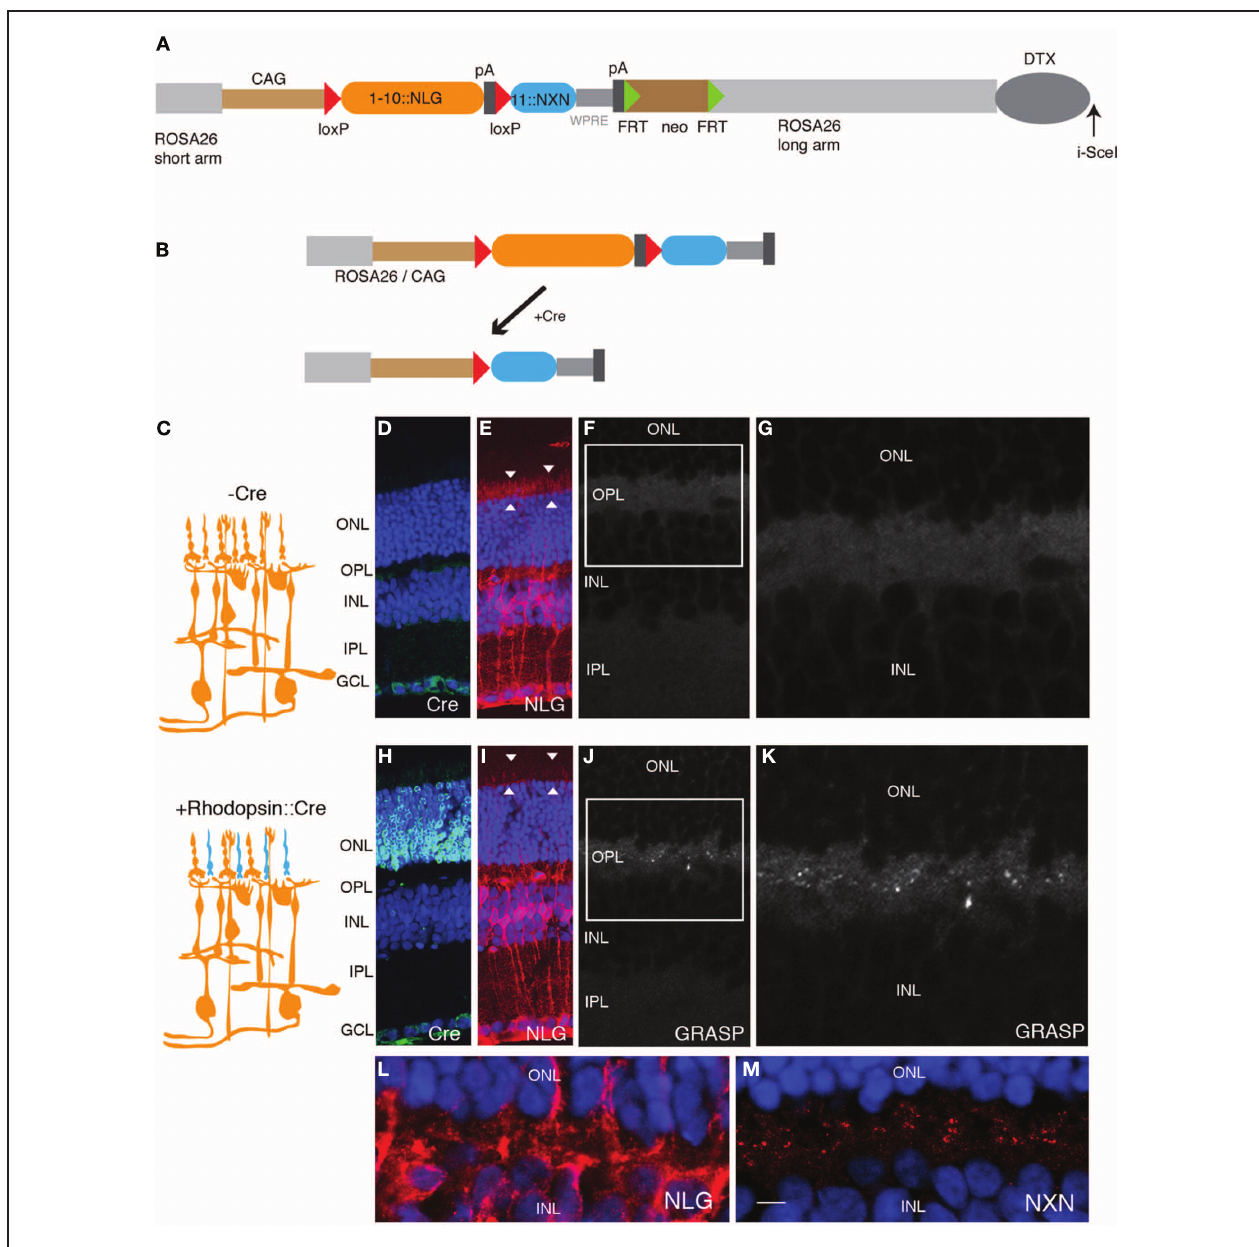
FIGURE 2 | Generation of GRASP knock-in mice. (A) Targeting construct for generation of mGRASP1 mice. sGFP1–10::NLG was placed